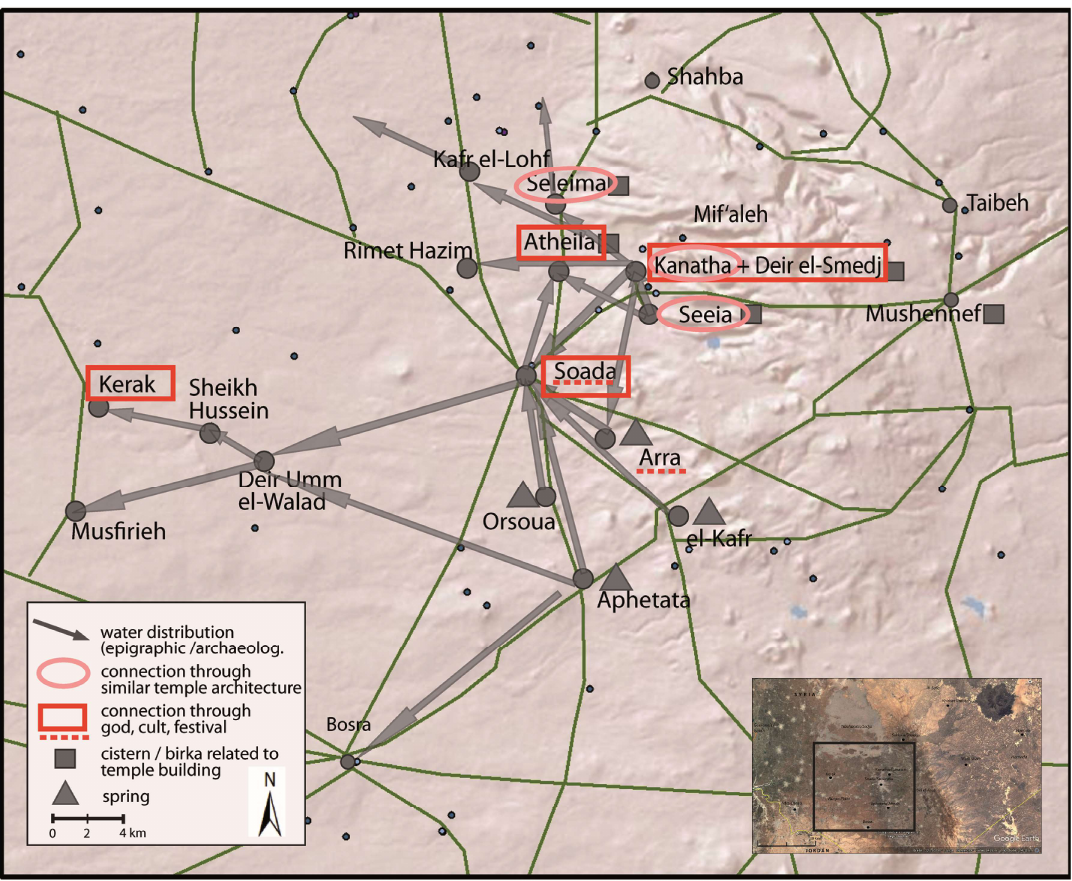
Figure 7. Inscriptions pointing to bi-directional relationships between the settlements. (a) The people from Kerak in the plain of Nuqra worship Zeus Megistos at Kanatha, located 20 km to the east of Kanatha, from where it received water. [85] (no. 2412d), [86] (no. 9799). (b) Inscription from Aphetata/el-Afineh about the channels of water ( agogoi hydatôn ) from Kanatha. [85] (no. 2296. 2297).